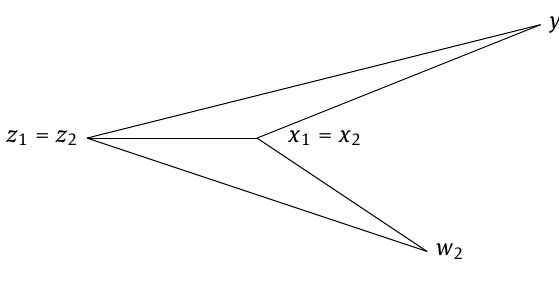
Figure 7.4: Points in R 2 appeared in the proof of Lemma